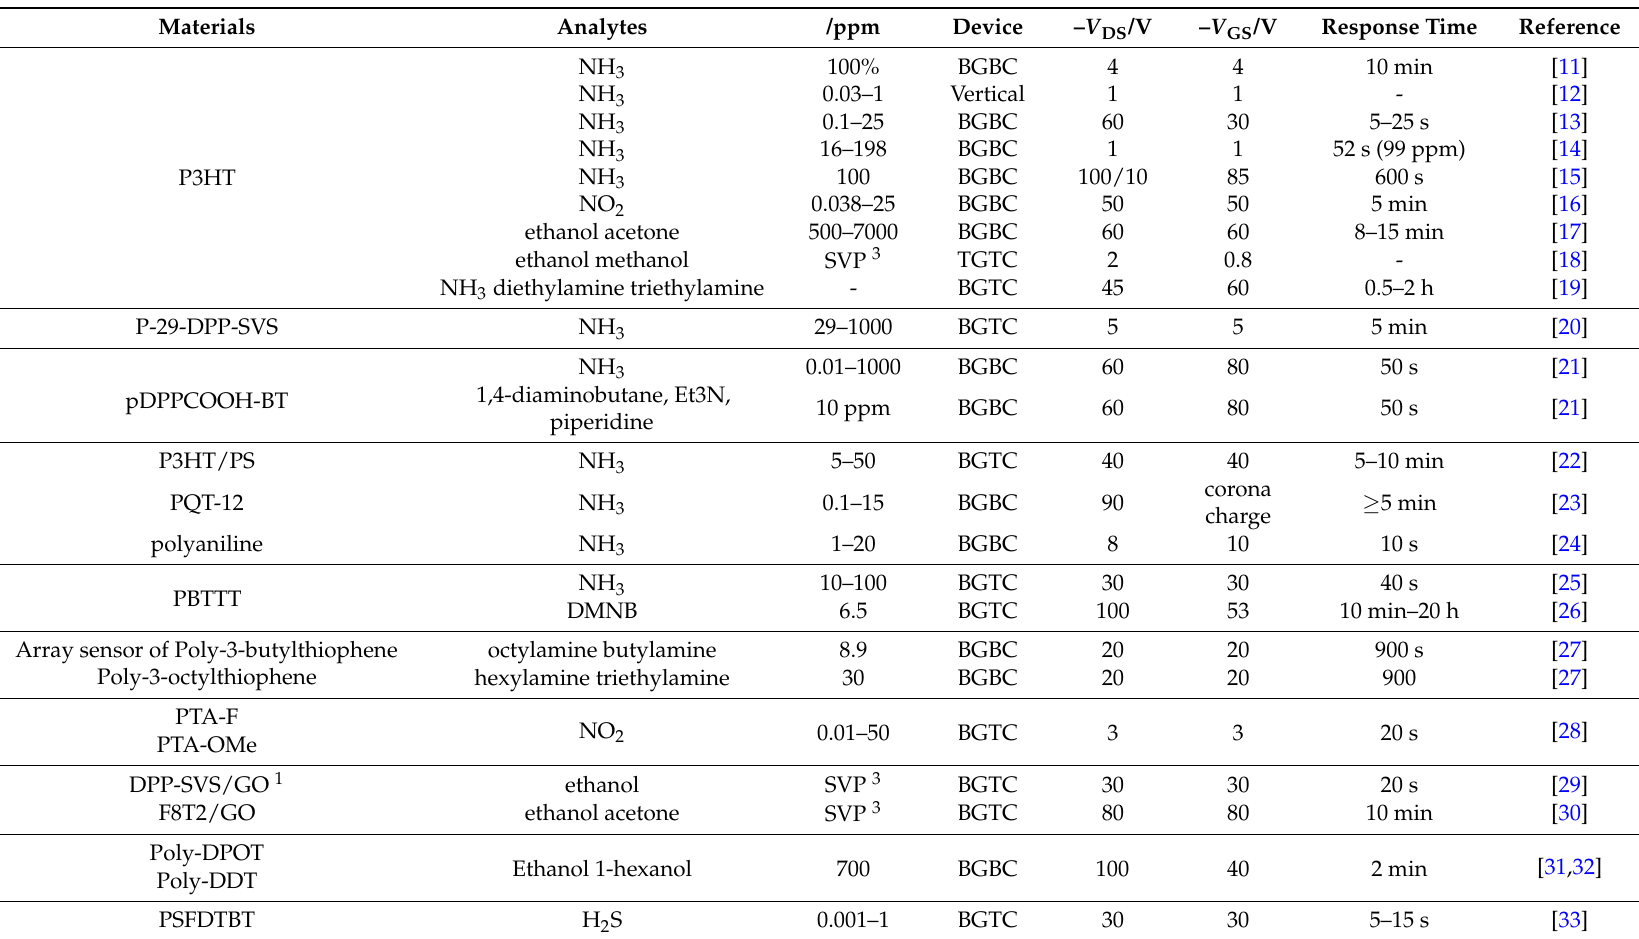
Table 1. Summary of the sensing polymer semiconductors and the key parameters of PFET